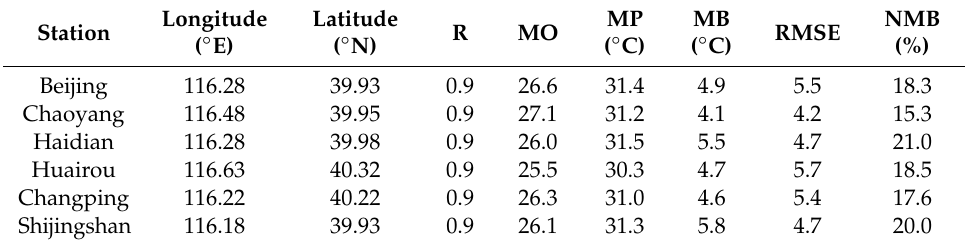
Table 1. Statistical parameters of the Weather Research and Forecasting Model (WRF) simulated air temperature in six stations in July and August